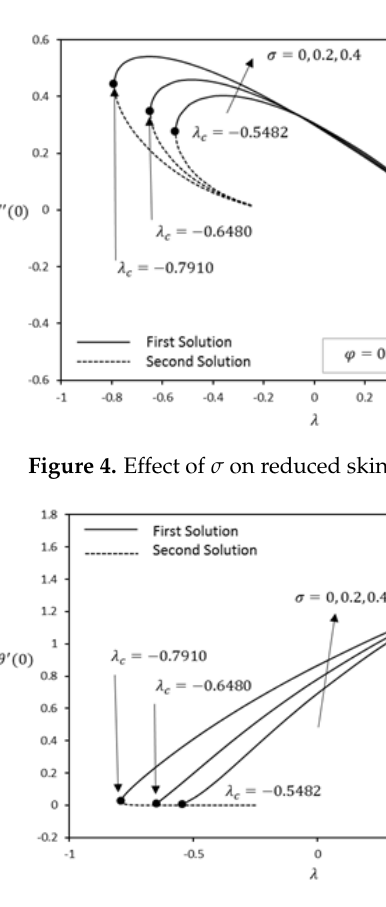
Figure 5. Effect of σ on reduced heat transfer ( ) 0 θ′− .